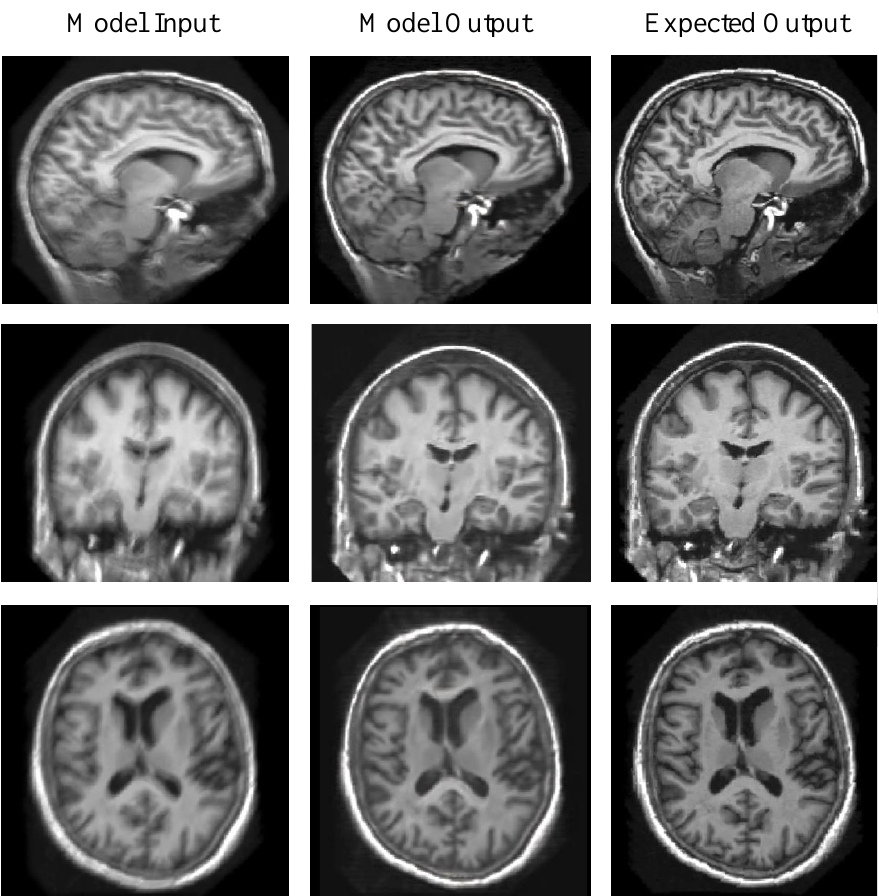
Figure 4. Visual Assessment of MC-GAN on Reducing Synthetic Motion Blurs. Left column: simu- lated motion blurs using random kernels (Section 4.2.2). Middle column: model-corrected output. Right column: ground truth images. From top to bottom rows are images from sagittal, coronal, and axial planes,